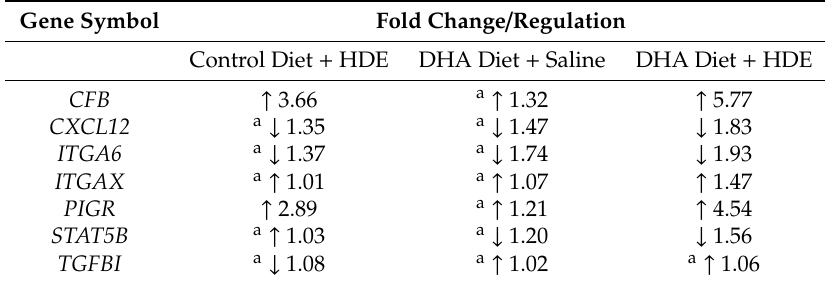
Table 4. Fold regulation of expressed genes in diet / exposure groups compared to control diet + saline exposure